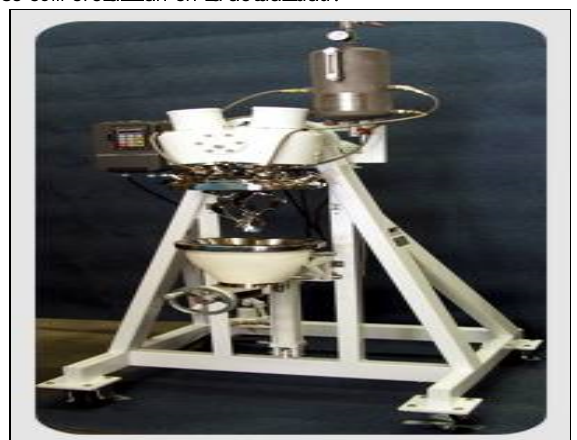
Figura 3: Reactor químico cónico vertical 4 pulgadas y mezclador en forma de cuchillas helicoidal cónico.